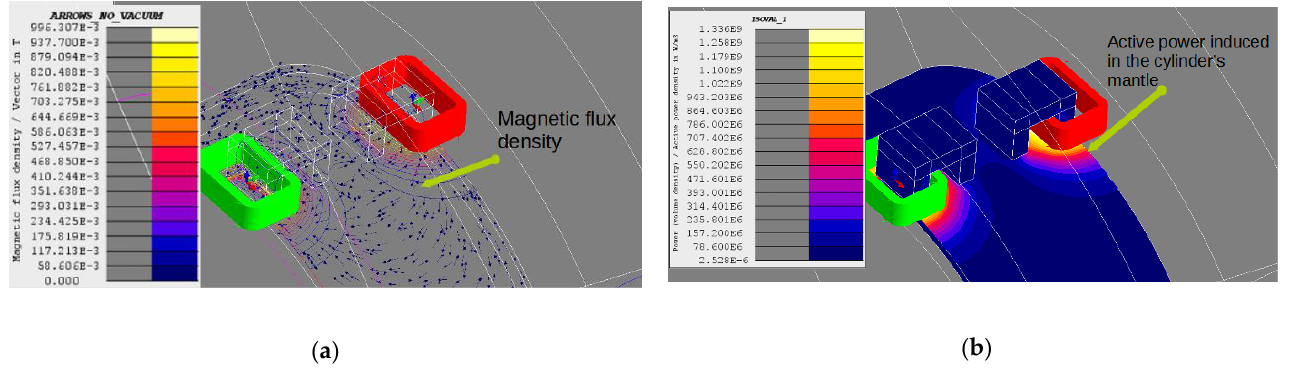
Figure 9. Distribution of magnetic induction ( a ) and active power ( b ) on the surface of the cylinder. For the calculated active power, the temperature distribution in the cylinder area covered by the electromagnetic influence of the inductor is then determined, taking into account the nonlinear relationship of thermal conductivity λ and temperature T. This feedback is represented by block [2] in Figure 8. Due to the fact that, in the modeled process, the surface temperature of the cylinder does not exceed the Curie temperature T cur , it is possible, without making a significant error, to uncouple the electromagnetic and temperature fields, so that after calculating the temperature distribution T there is no need to recalculate the active power p v in a given calculation step. This significantly accelerates the calculations. After calculating the temperature distribution on the surface of the cylinder, the transition to the next calculated time interval takes place t = t + ∆ t, i.e., the cylinder is moved by an angle α = α + 10 ◦ . Taking into account the thermal history from the previous interval step, the redistribution of the active power on the surface of the